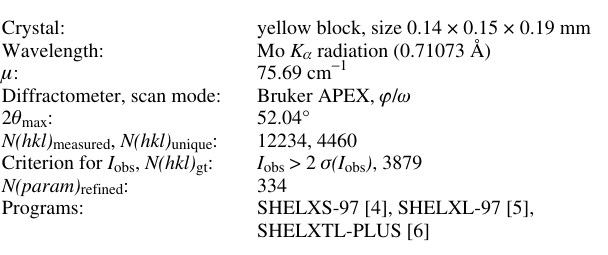
Table 1. Data collection and